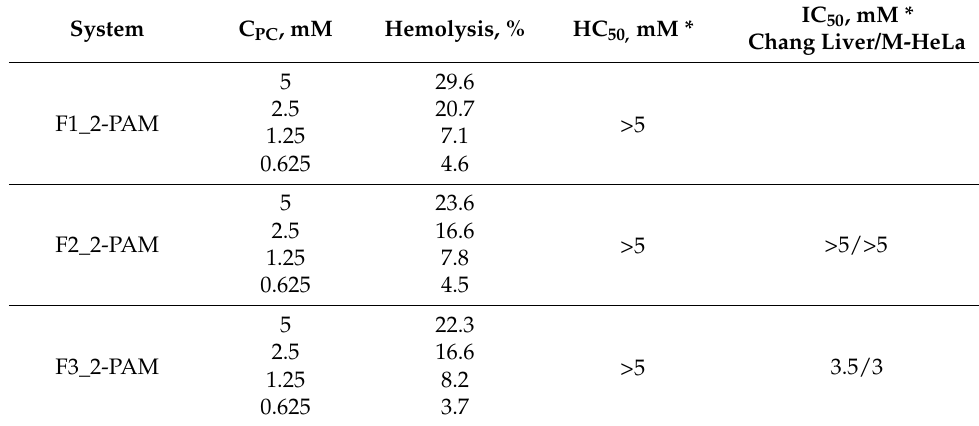
Table 5. Hemolytic activity and cytotoxicity of 2-PAM-containing chitosomes: The concentration of Cs is 0.05%.